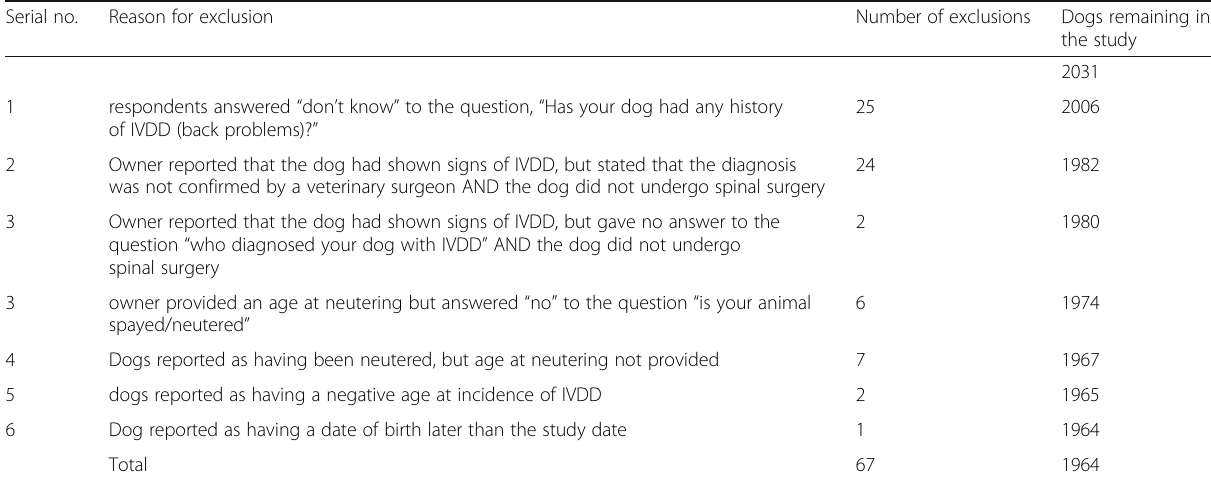
Table 1 Exclusion of dogs from the study Serial no.